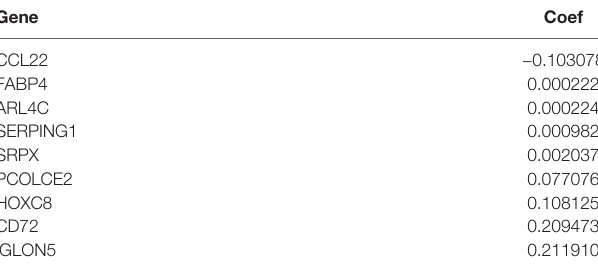
TABLE 2 | Nine key prognostic